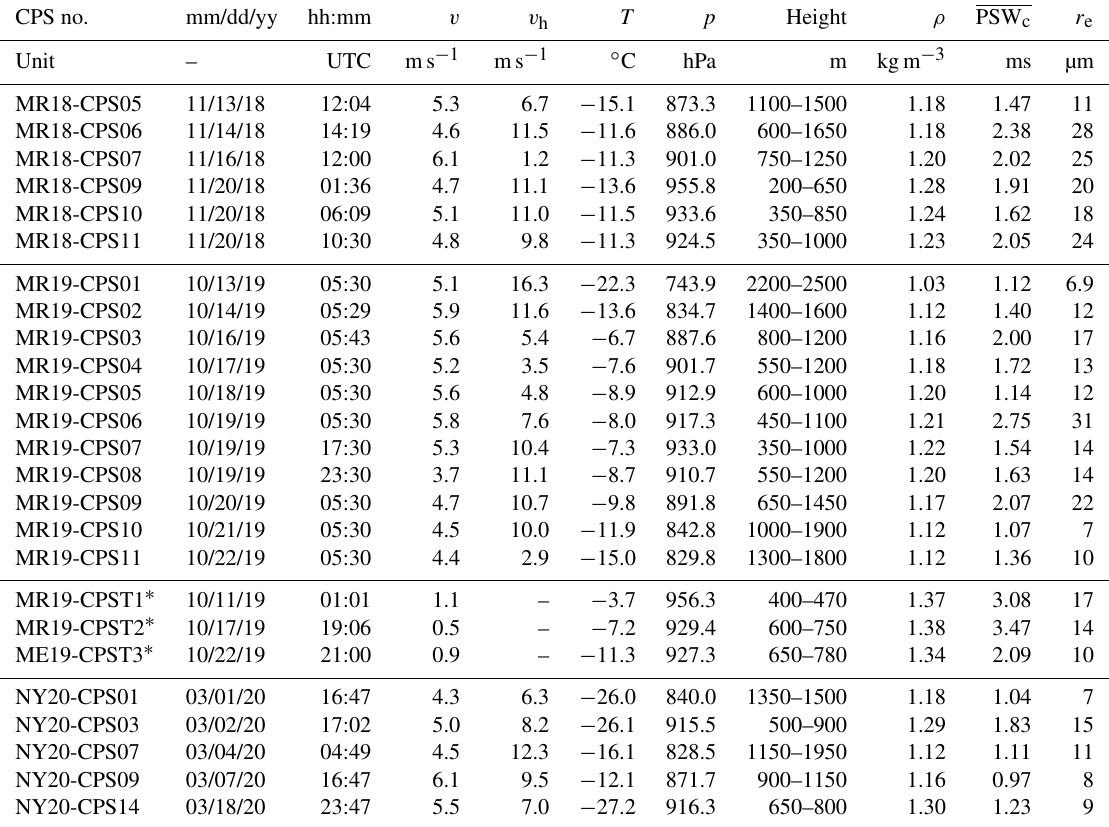
Table 1. Case number of the CPS launch, launch date, ascending speed, horizontal wind speed, air temperature, air pressure, height of cloud layer, air density, cutoff PSW, and effective radius. CPS